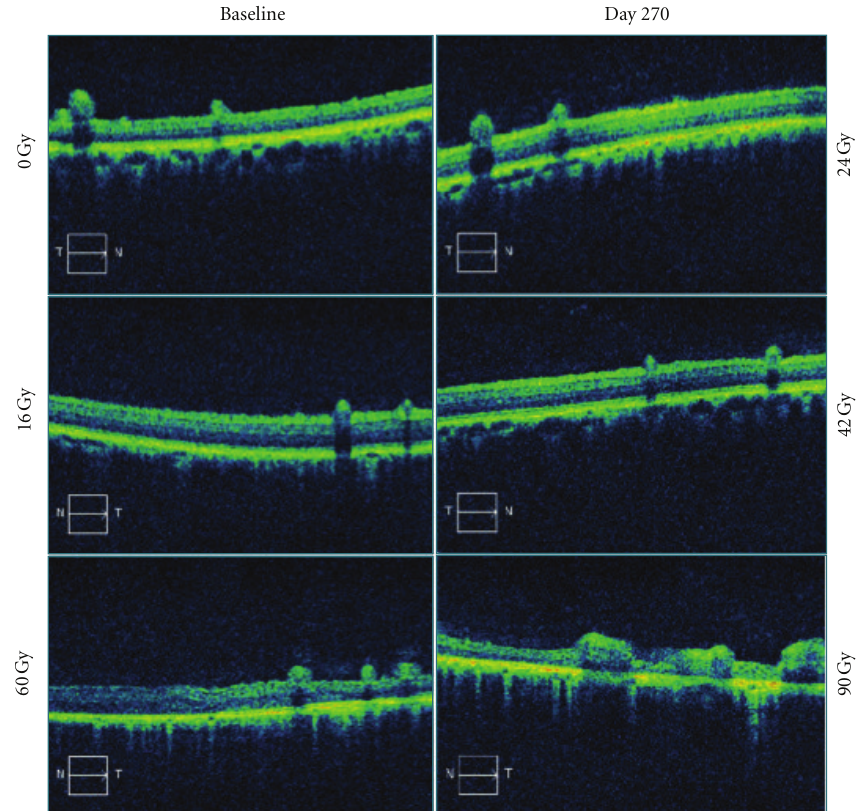
Figure 4: Representative OCT montage of a 24Gy and a 90 Gy animal, demonstrating dose-dependent treatment e ff ect at day 270. In the 24Gy swine, no obvious defects were seen with regard to retinal thinning or RPE hyperreflectivity. In 90Gy animal, there is a dose-dependent decrease in retinal thickness and an increase in the RPE hyperreflectivity indicating significant retinal scarring. No findings were noted at 0 or 16 Gy, and progressively worsening retinal injury was seen at the 42, 60, and 90Gy